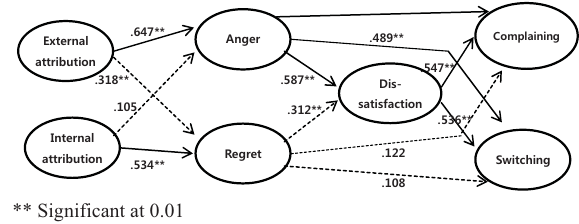
Figure 2: Path analysis